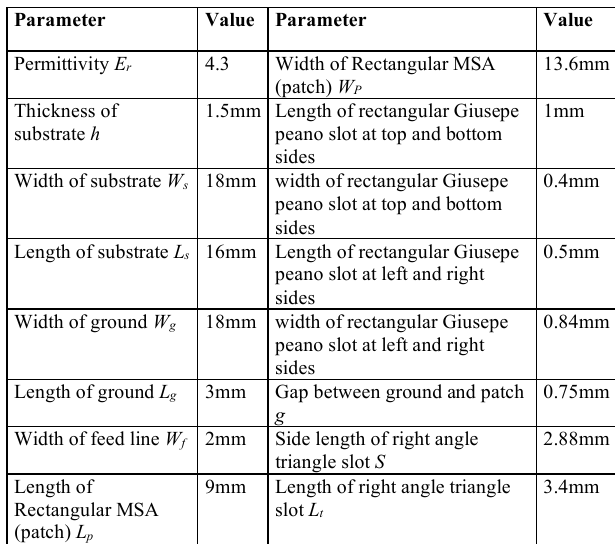
Table 1: The dimensions of Proposed Model